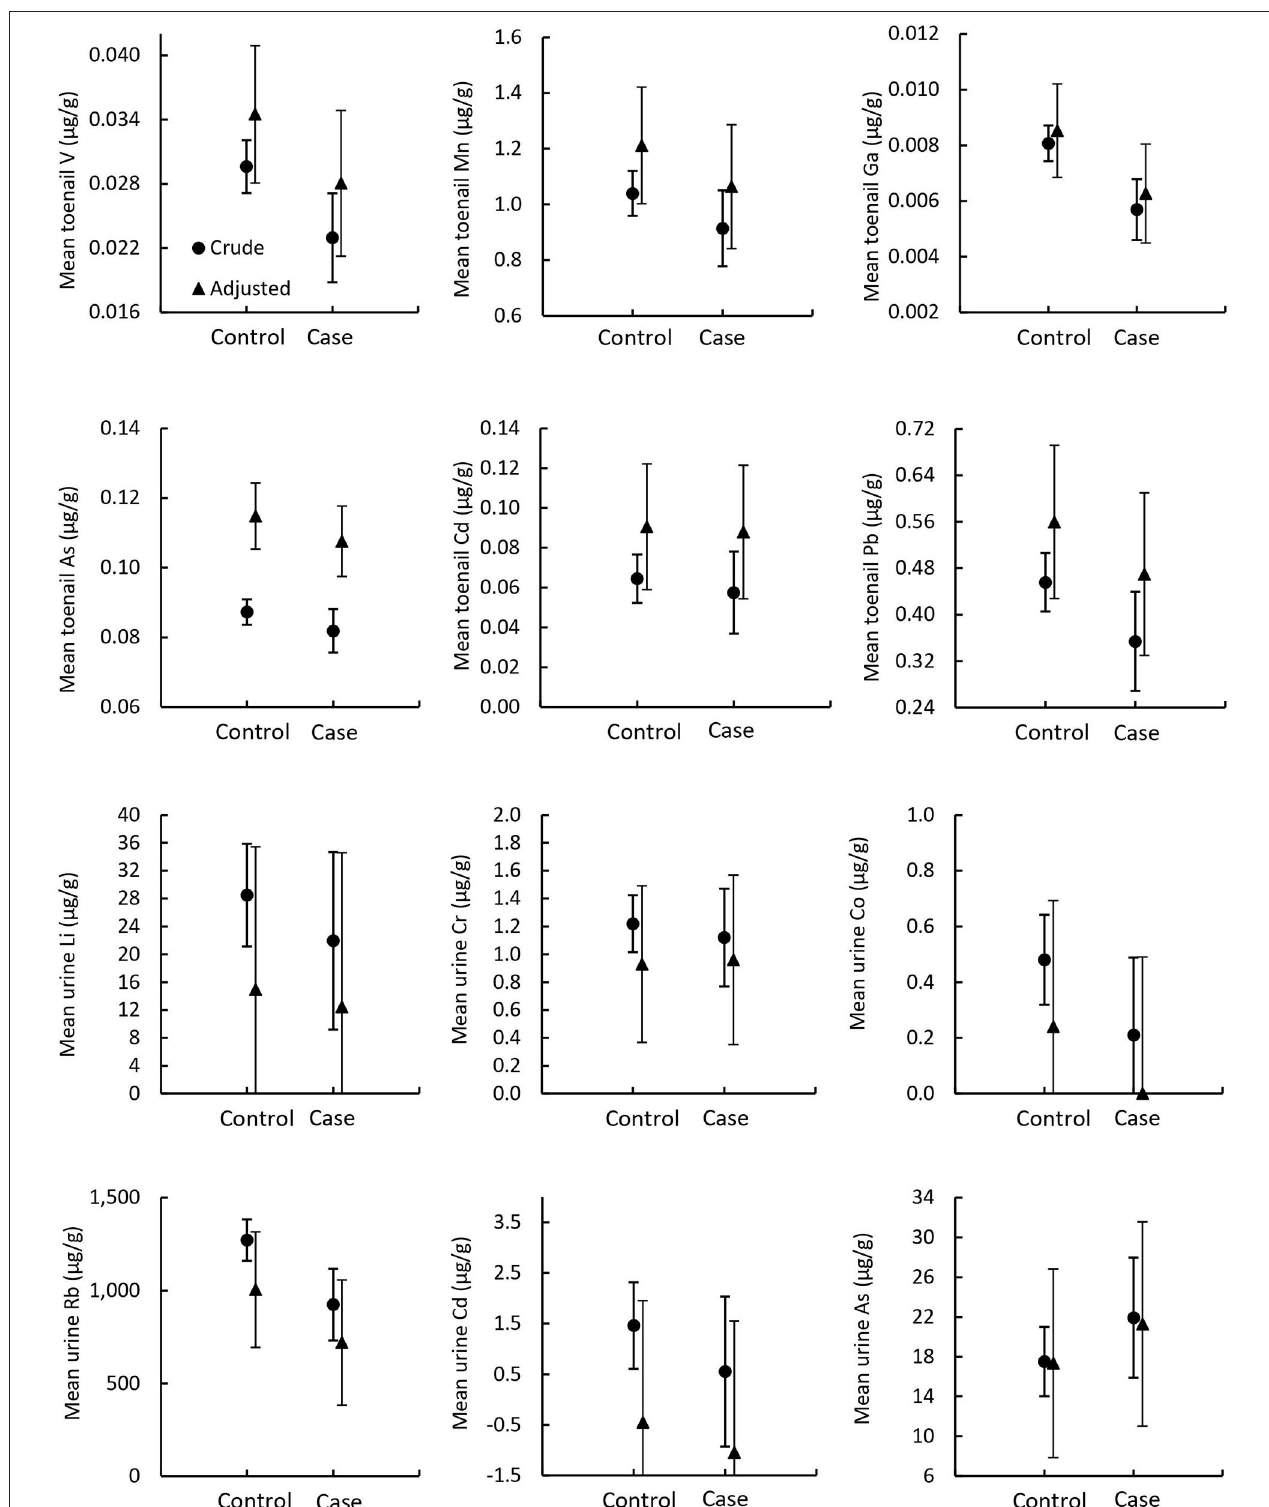
FIGURE 4 | Mean metallome concentrations in toenail and urine samples. Circles indicate crude means from MANOVA models and triangles indicate adjusted means from MANCOVA models. Error bars indicate standard error.